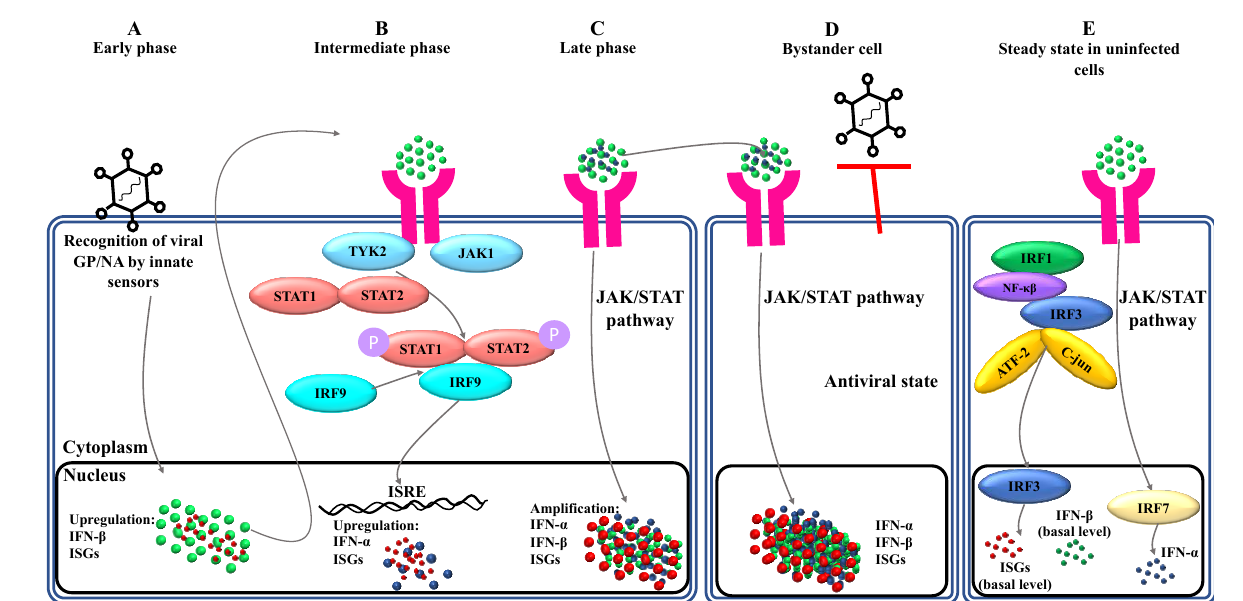
Figure 2. The Triphasic Model of Induction of Type I IFN Genes. ( A ) The expression of the interferon (IFN)- β gene is immediately upregulated following recognition of viral pathogen-associated molecular patterns (PAMPs). If the virus is successfully eliminated, no additional IFNs are induced. ( B ) Otherwise, further production of interferon regulatory factor (IRF)-3-induced IFN-β results in continual IFN-α/β receptor (IFNAR) signaling and thereby IRF-7-mediated upregulation of the IFN-α gene. ( C ) Subsequently, in the late phase of viral infection, the newly produced IRF7, in cooperation with IRF3, activates a positive feedback loop to amplify the induction of IFN-α/β genes to efficiently eliminate the invading virus. ( D ) Via paracrine interaction with IFNARs, type I IFNs create an antiviral state in bystander cells and, therefore, reduce or prevent virus spread to neighboring cells. ( E ) In a steady state, basal expression and signaling of IFN-β through IFNARs in uninfected cells is speculated to intrinsically provide protection against the potential for viral infections. Other